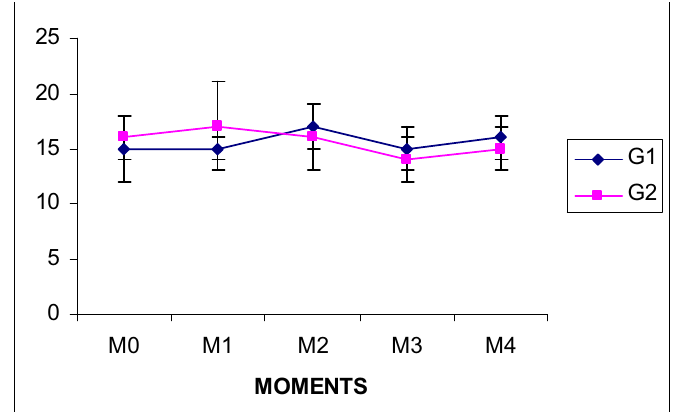
FIGURE 4 - Mean values for hydroproline concentration (mg/100 mg of tissue) of samples for the distal colon segment in the two groups at the experimental